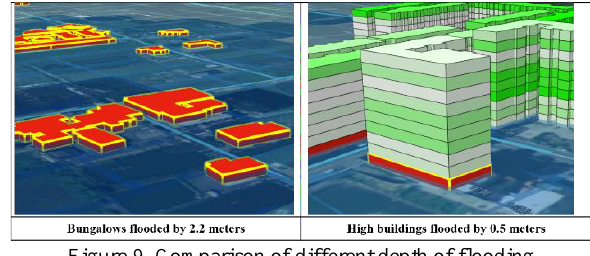
Figure 9. Comparison of different depth of flooding